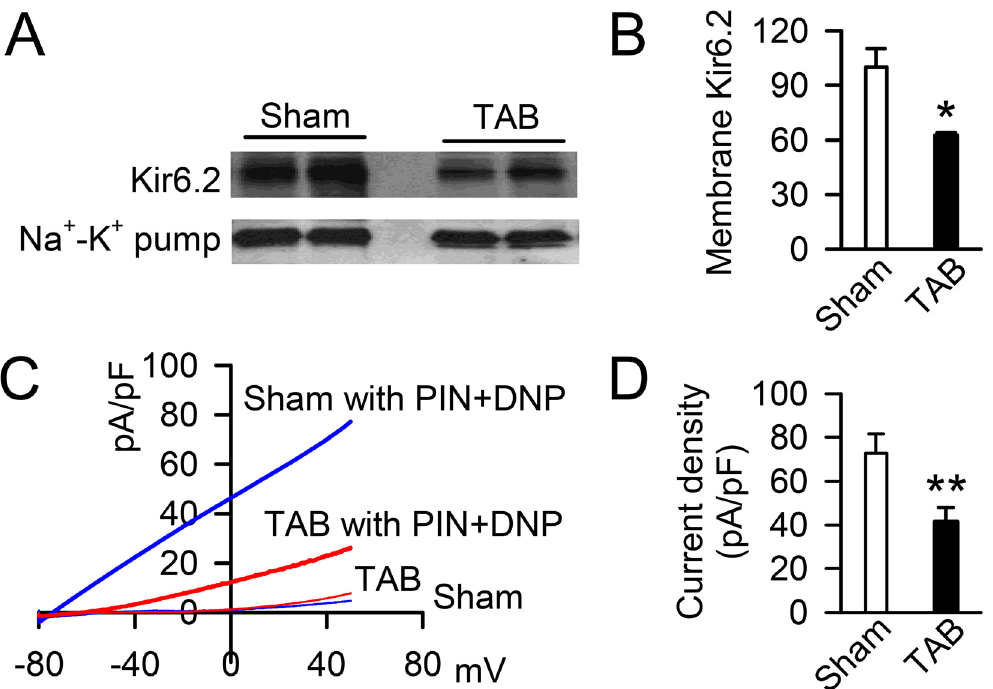
Fig 3. K ATP channel surface expression is down-regulated in ventricles of hearts after transverse aortic banding. A) Representative western blots of the K ATP Kir6.2 subunit and the sodium-potassium pump (Na + -K + pump) from the biotinylated membrane fraction of ventricular tissue from isolated hearts of sham and TAB mice. B) Summary of ventricular membrane Kir6.2 expression normalized to Na + -K + pump expression in hearts of sham and TAB mice ( * p < 0.05 vs . sham). C) Representative current profiles of isolated left ventricular myocytes before and after application of the K ATP channel activators, pinacidil (PIN, 100 μ M) and 2,4-dinitrophenol (DNP, 200 μ M). D) Summary of K ATP channel current density (after-before K ATP channel activations) from isolated ventricular cardiomyocytes of sham and TAB mice ( ** p < 0.01 vs .